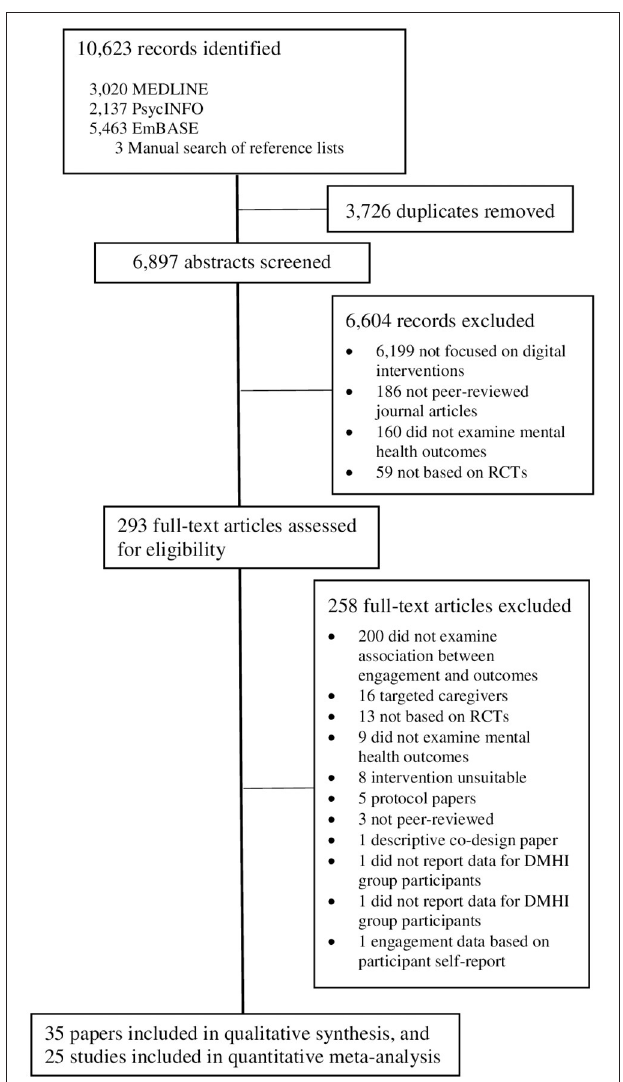
FIGURE 1 | PRISMA diagram for study selection process.